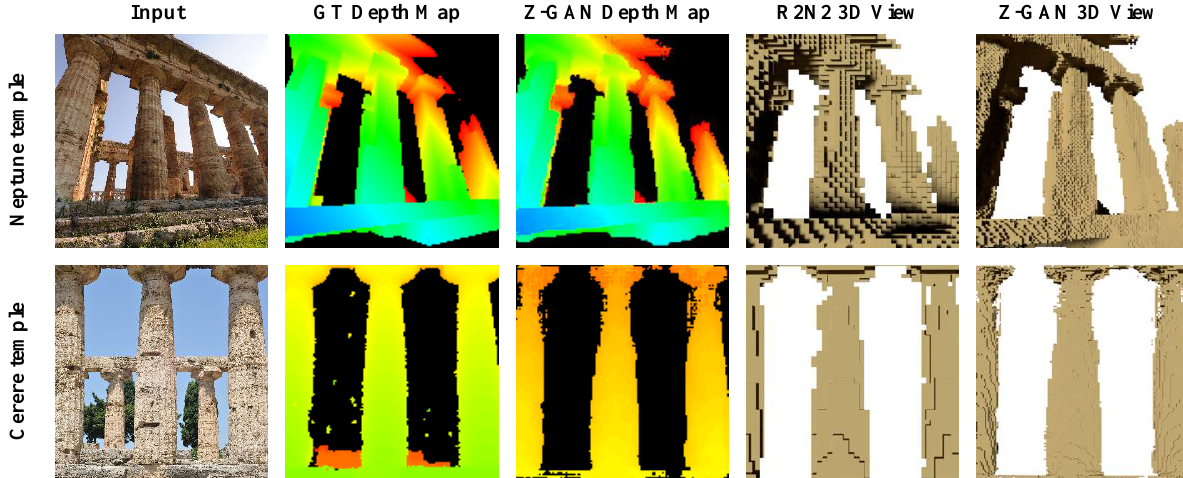
Figure 4: Results of 3D reconstruction using Z-GAN on the Neptune and Cerere temple datasets with respect to Ground Truth (GT) depth map and the state-of-the-art method R2N2.